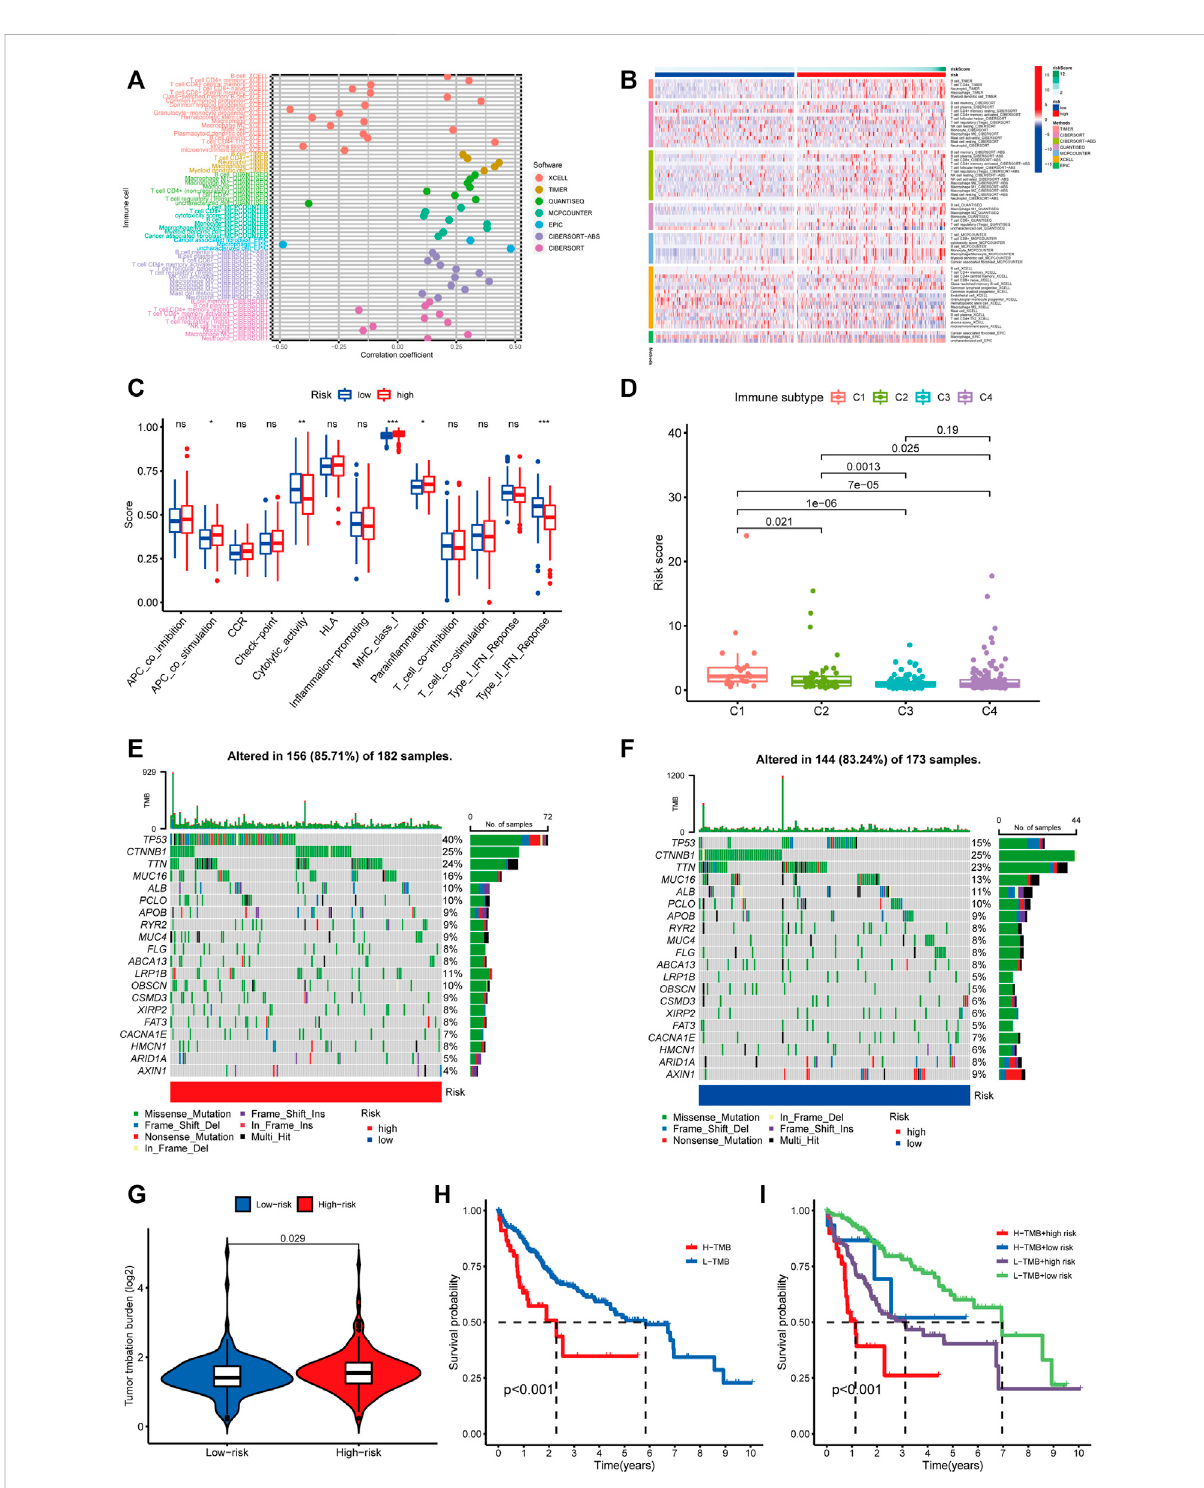
FIGURE 9 Estimating the correlation between m5C-related lncRNAs and immune in fi ltration and mutation analysis. (A) The correlation analysis of risk score and tumor-in fi ltrating immune cells by TIMER, XCELL, QUANTISEQ, MCPcounter, EPIC, CIBERSORT-ABS, and CIBERSORT software. (B) A heatmap indicating the differential immune responses between the high- and low-risk groups based on the above seven software. (C) The differentialscoresof13immune-relatedfunctionsinhigh-andlow-riskgroups. (D) Comparisonoftheriskscoreindifferentimmunein fi ltration subtypes.* p < 0.05,** p < 0.01,and*** p < 0.001;ns,non-signi fi cant. (E,F) Waterfallplotofthe20topmutatedgeneswithhighmutationfrequencyin thehigh-riskgroup (E) andlow-riskgroup. (F,G) Thedifferentmutationeventbetweentwogroups. (H) KManalysisbetweenhigh/lowTMBgroups. (I) Comparative analysis of prognosis combining risk score and